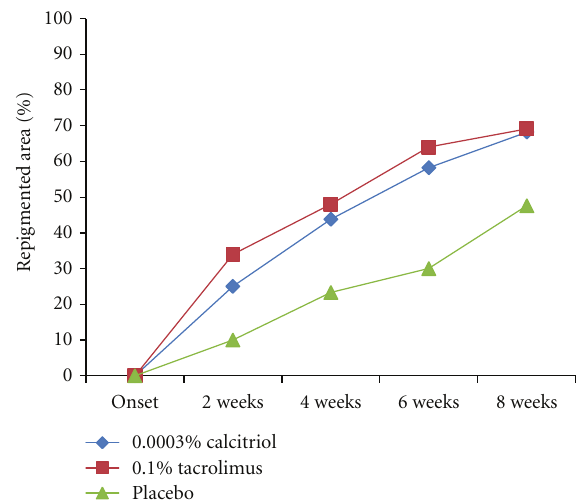
Figure 1: Mean percentage change in the depigmented area of PA target lesions during the study for calcitriol ( n = 19), tacrolimus ( n = 18), and placebo ( n = 19). At 8 weeks, there were di ff erences among groups (one-way ANOVA, P < 0 . 001), but no di ff erence was noted between calcitriol and tacrolimus ( t test, P = 0 . 9).